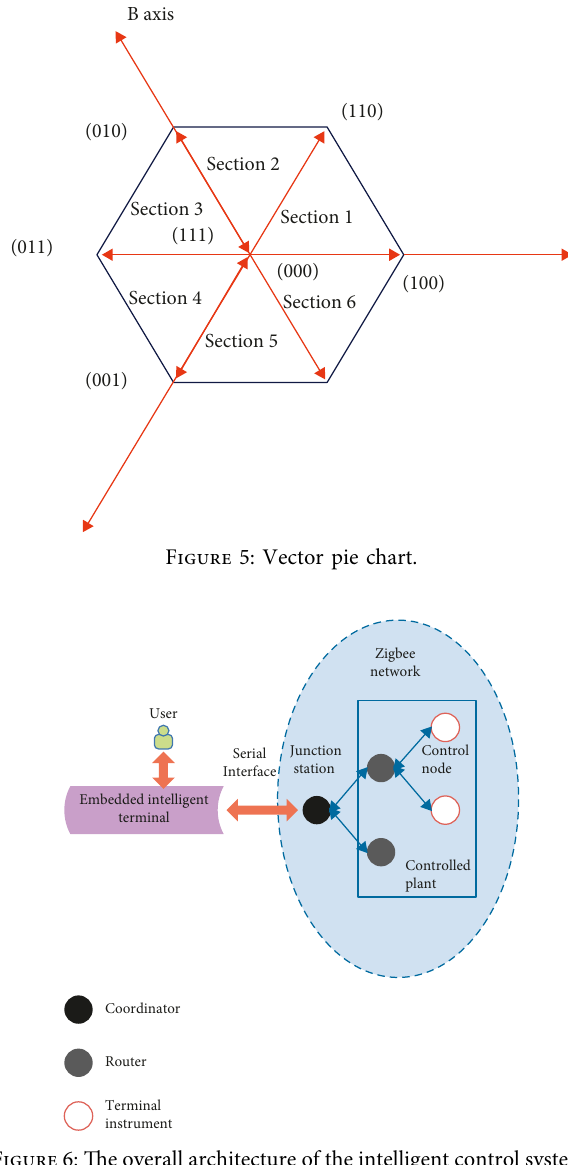
Figure 6: The overall architecture of the intelligent control system.